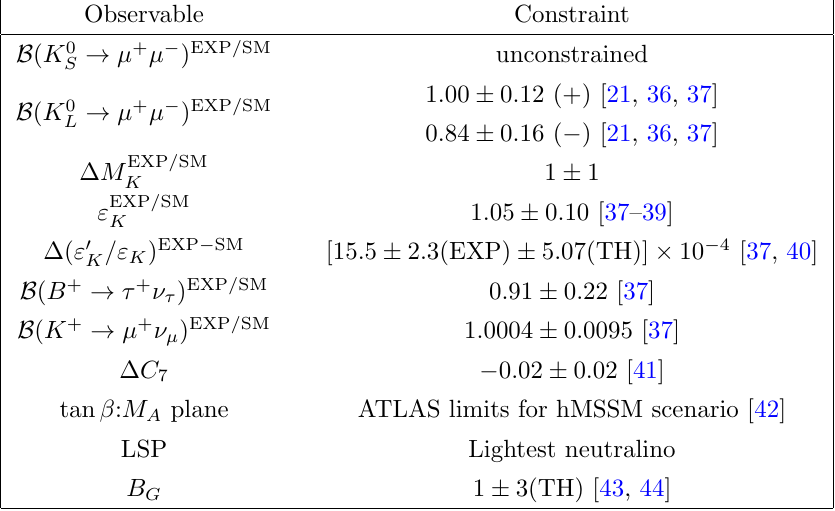
in eq. (2.16) (see refs. [21, L(cid:13)(cid:13)